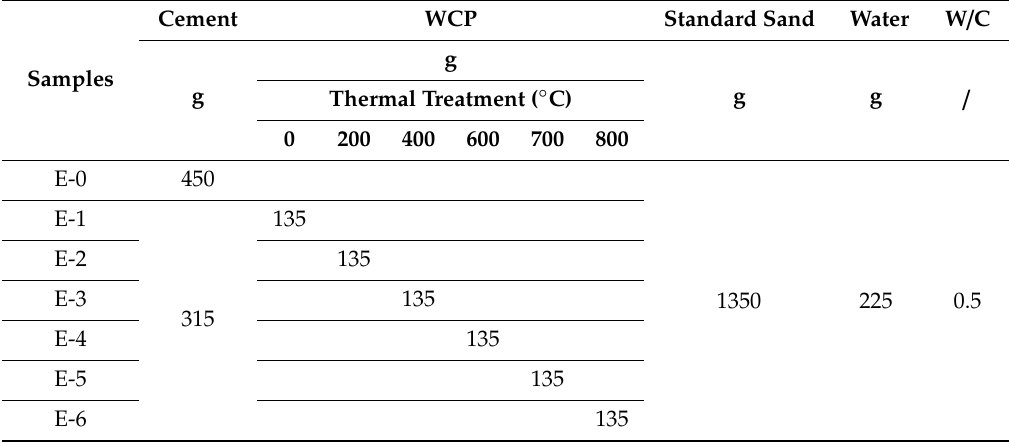
Table 2. Recipe of the experiment according to Chinese Standard GB / T